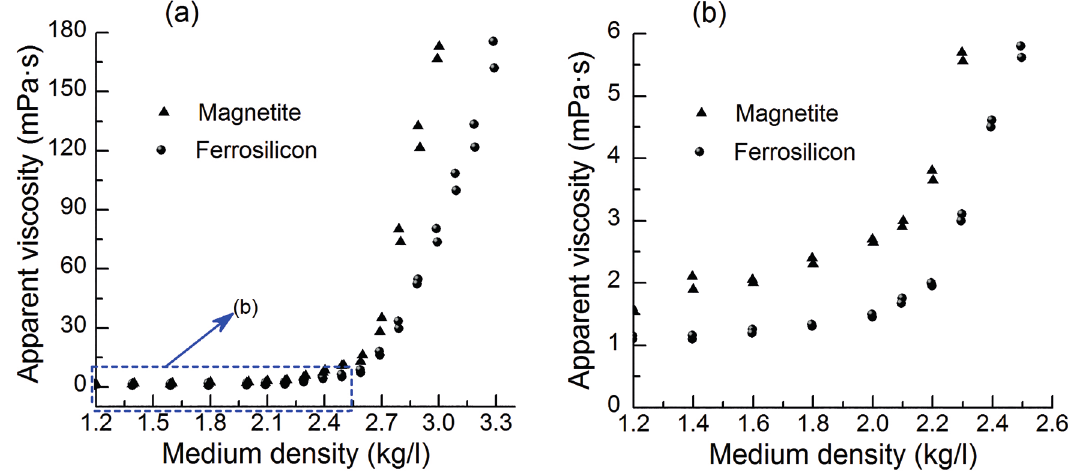
Figure 8: (a) Effect of medium composition on apparent viscosity. (b) Selected zone of (a).